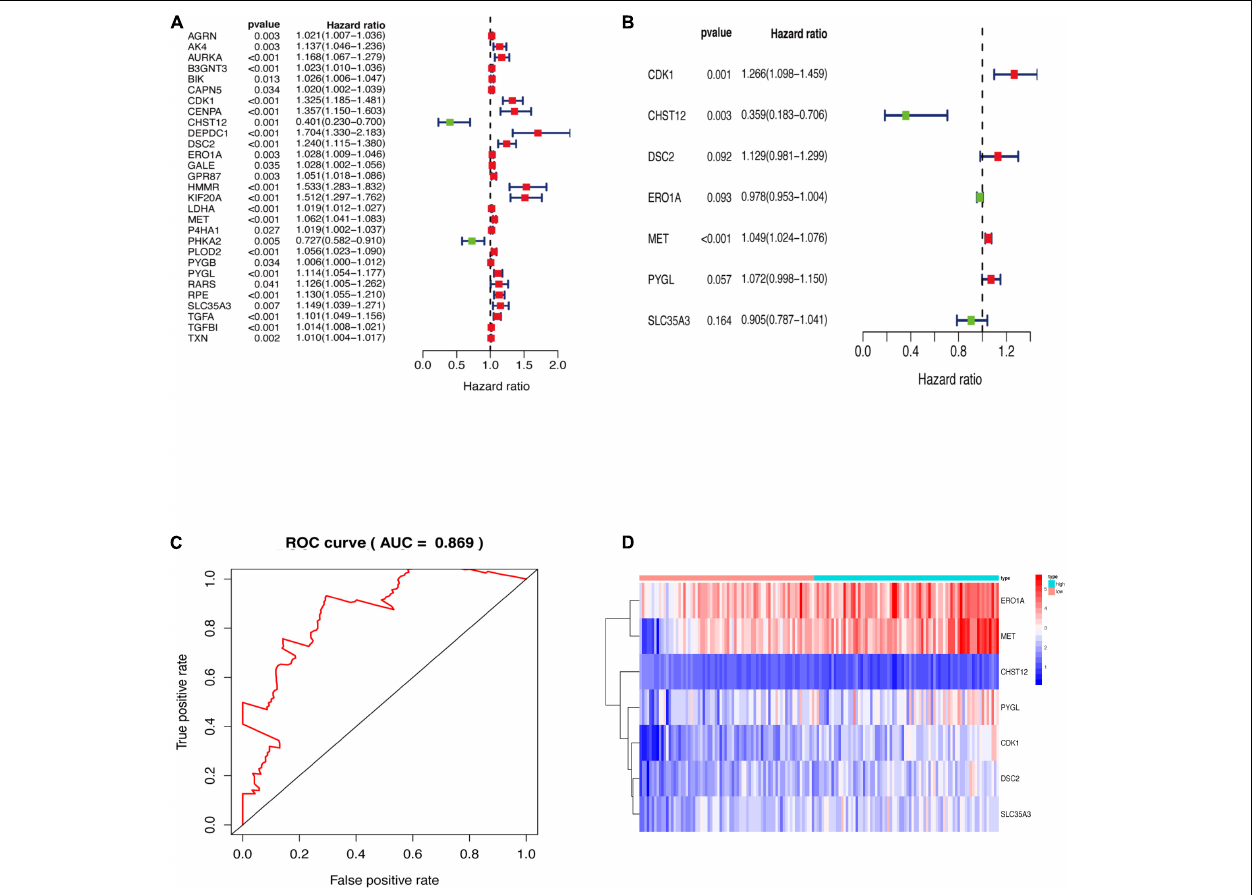
FIGURE 2 | (A) GRGs associated with prognosis. (B) Key model GRGs. (C) Time-dependent ROC curve for GRGs in the training cohort. (D) Relative expression of model